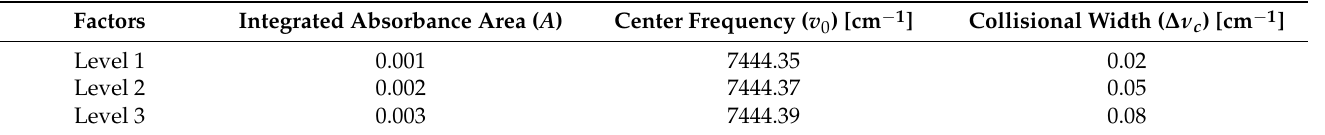
Table 1. The factors and levels in the Orthogonal Test.